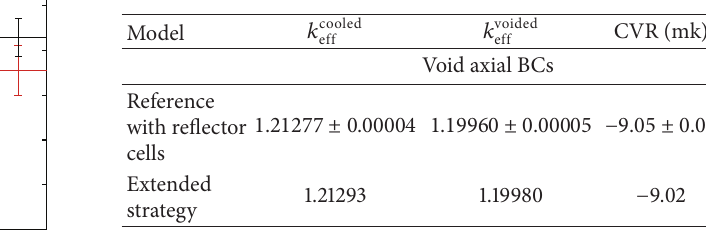
Table 2: Channel multiplication factors and CVRs for models with axial reflector